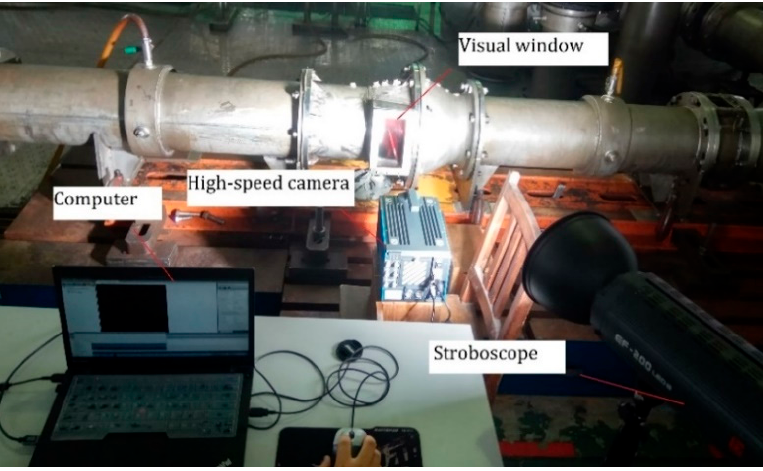
Figure 1. High-speed photography visualization system [28].